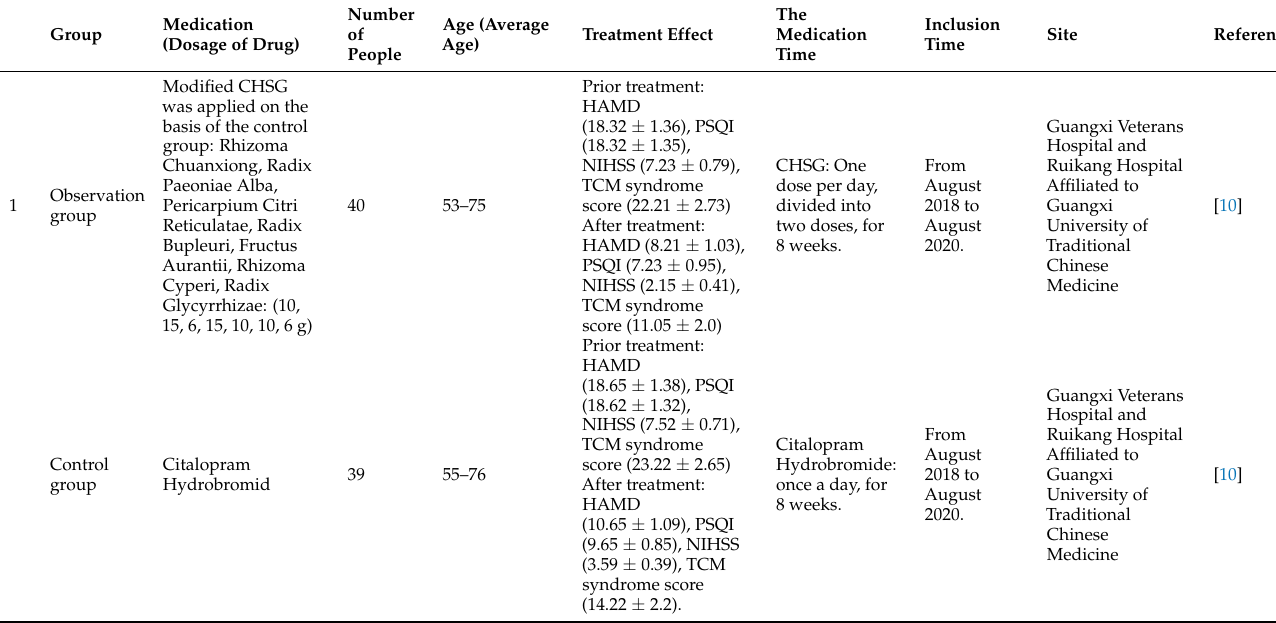
Table 2. Clinical applications of CHSG in the treatment of